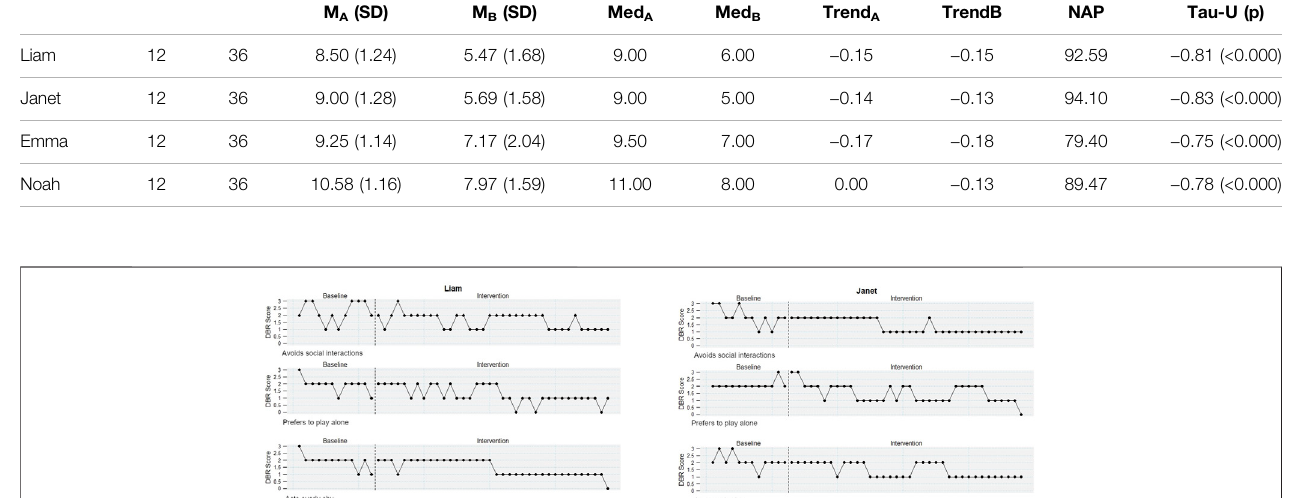
Frontiers in Education |